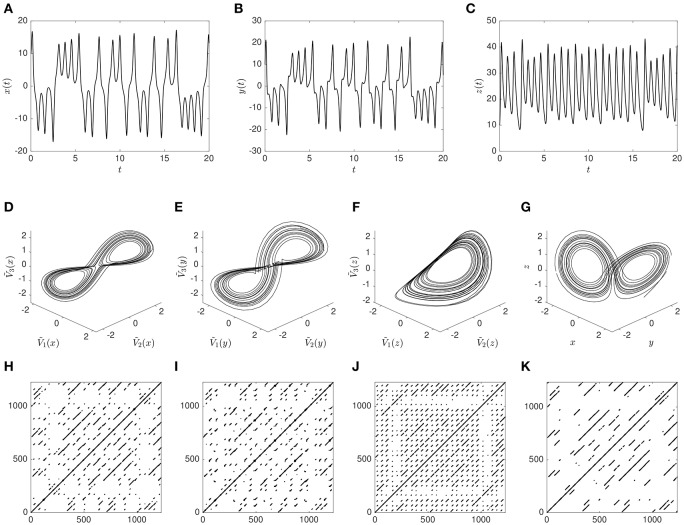
The time series for x (A), y
(B), and z
(C) obtained by numerical integration in the solution interval. The Lorenz attractor (G) is the phase space plot of x, y, and z shown in z -scored dimensions. The reconstructed attractor based on time delayed embedding of x, y, and z respectively, with D = 3 and τ = 4, is shown in (D–F) (also in z -scored dimensions). Finally recurrence plots, using a threshold T = 0.1 to define a recurrence, are shown for the reconstructed attractors, based on x
(H), y
(I), and z
(J); as well as based on the original attractor (K) with a threshold T = 0.08.